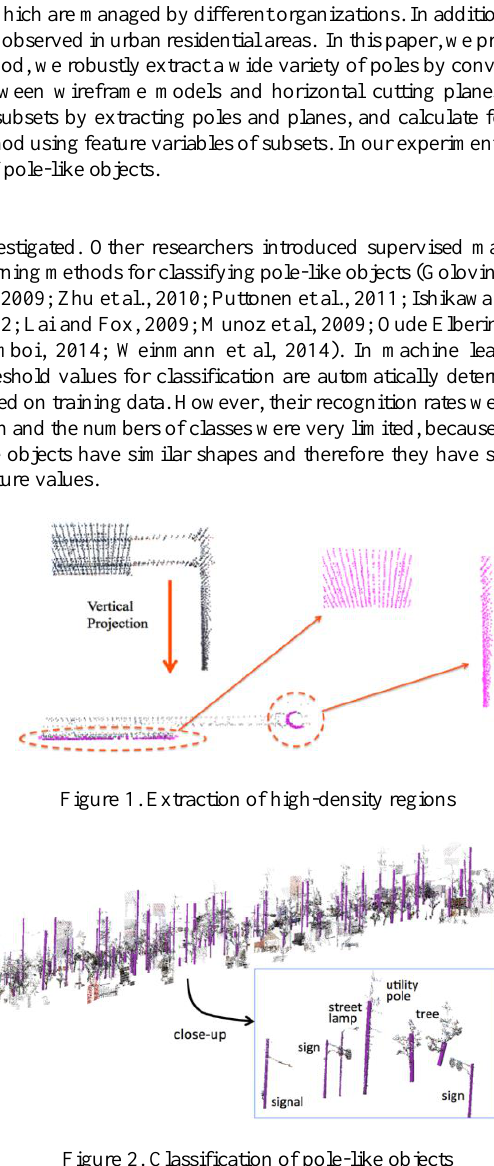
Figure 2. Classification of pole-like